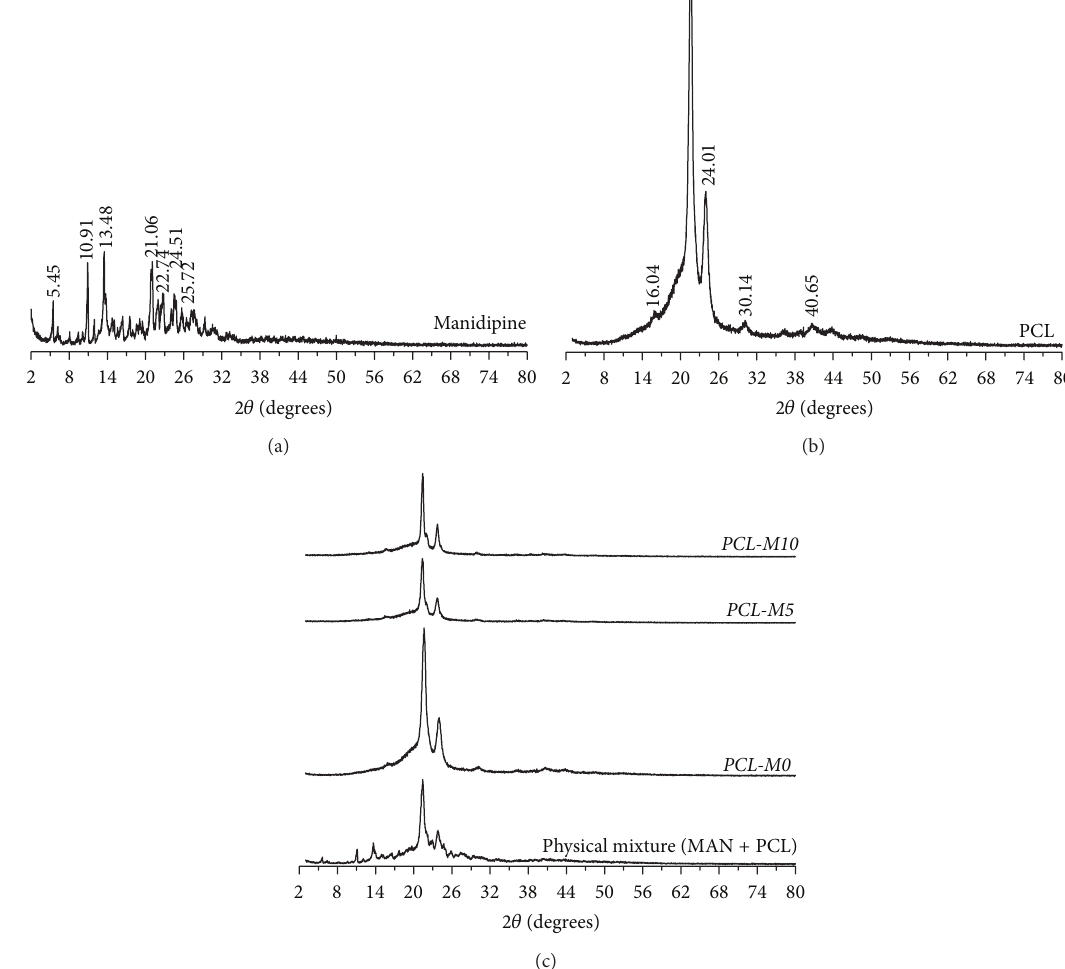
between 208 and 522 ∘ C ( Δ𝑚 = 87.46 %). On the other hand, TGA curves of polymers presented a single event of mass loss at the temperature range of 247 and 467 ∘ C ( Δ𝑚 = 97.84 %) and 224 and 291 ∘ C ( Δ𝑚 = 96.91 %) for PCL and PHBV,